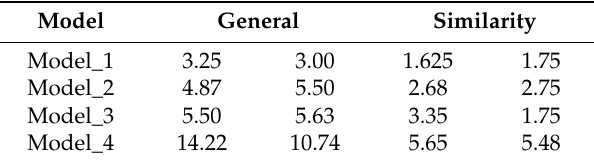
Table 3. Comparison of average pixel errors under different illuminations by robust enhancement algorithm.